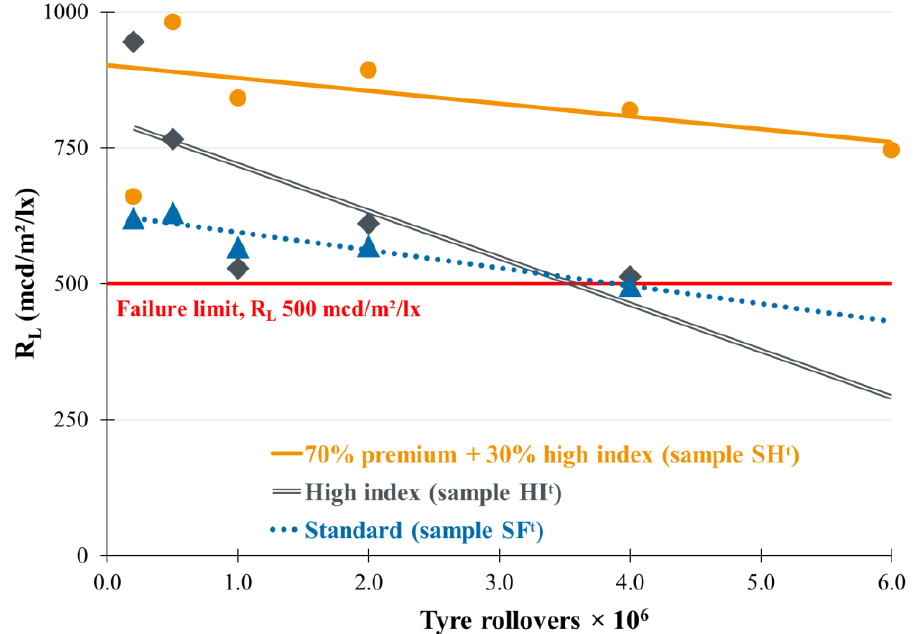
Figure 3. Loss of R L (dry conditions) under turntable testing.